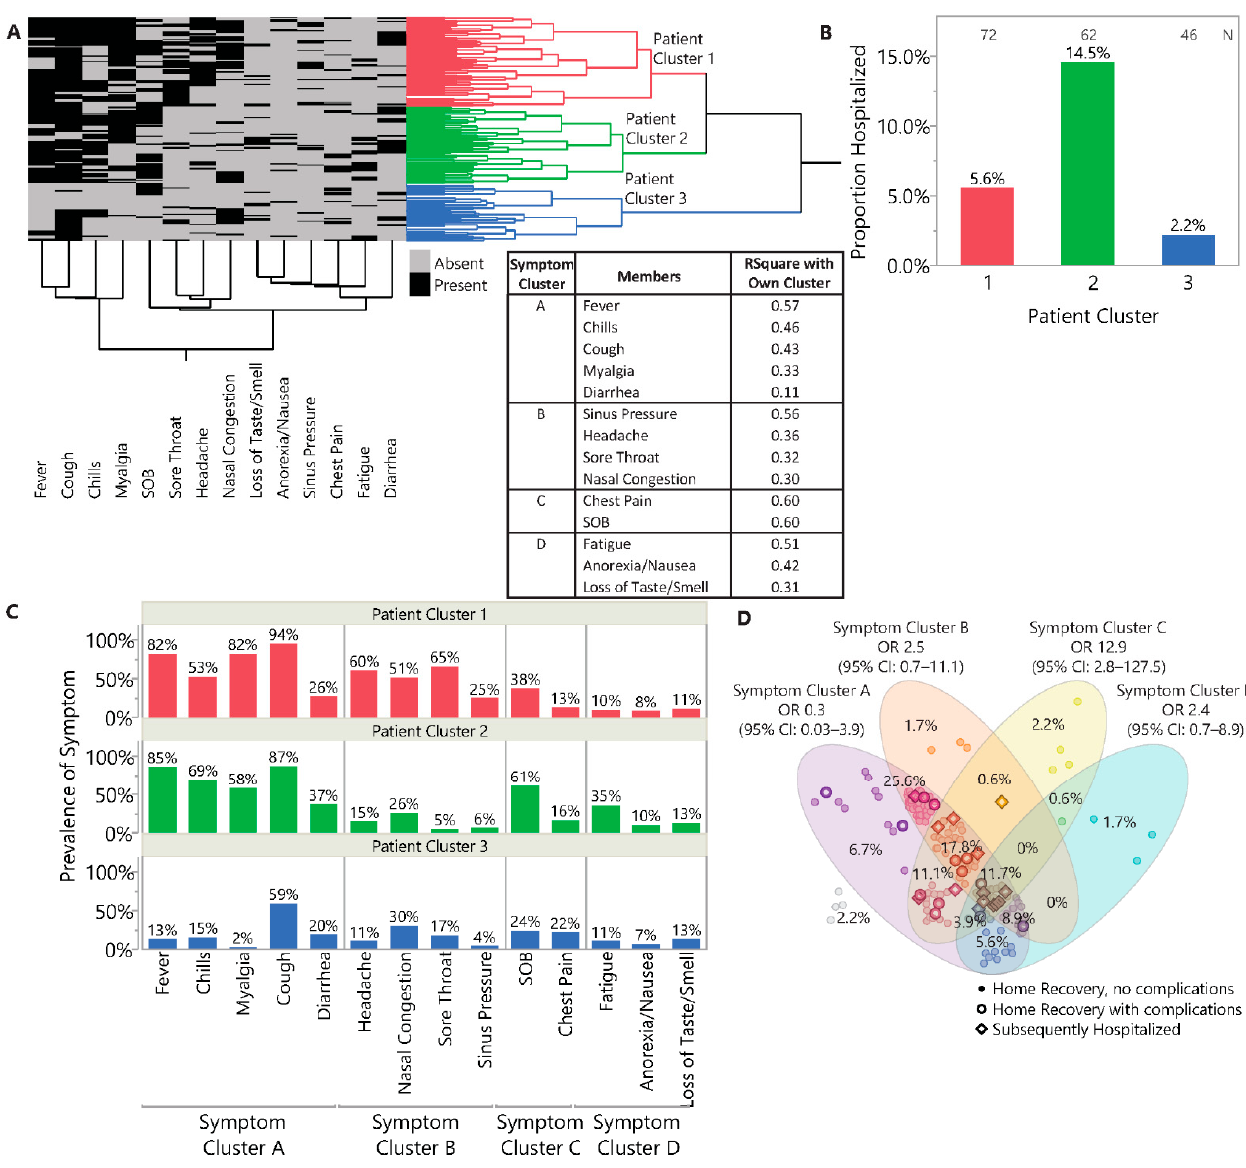
Figure 3. Symptom clusters using hierarchal and variable clustering. ( A ) 2-way hierarchical clustering of symptoms shows three patient clusters/phenotypes and four clusters of co-occurring symptoms: symptom cluster A: flu-like with fevers, chills, cough, myalgia, diarrhea; symptom cluster B: upper respiratory, with nasal congestion, sinus pressure, sore throat, and headache; symptom cluster C: pneumonia-like, with shortness of breath and chest pain; and symptom cluster D: anorexia/nausea, fatigue, loss of smell/taste. ( B ) Patient cluster 2 is most associated with hospitalization, while cluster 3 had the lowest hospitalization rate . ( C ) Overall, cluster 1 patients had high prevalence of symptom cluster A (flu-like) and B (upper respiratory) symptoms. Cluster 2 patients experienced high prevalence of symptom cluster A (flu-like) and C (pneumonia-like) symptoms, including the highest prevalence of SOB among all patient clusters. Cluster 3 patients experienced few symptoms with the exception of cough. ( D ) Association of symptom clusters with outcome. Thirteen of 14 admitted patients had symptoms from Cluster C. Each data point represents a single patient and the marker symbols indicate types of outcomes. Four outpatients were asymptomatic. Odds ratio with 95% CI for the association with subsequent hospitalization for each symptom cluster are annotated at the top of the Venn